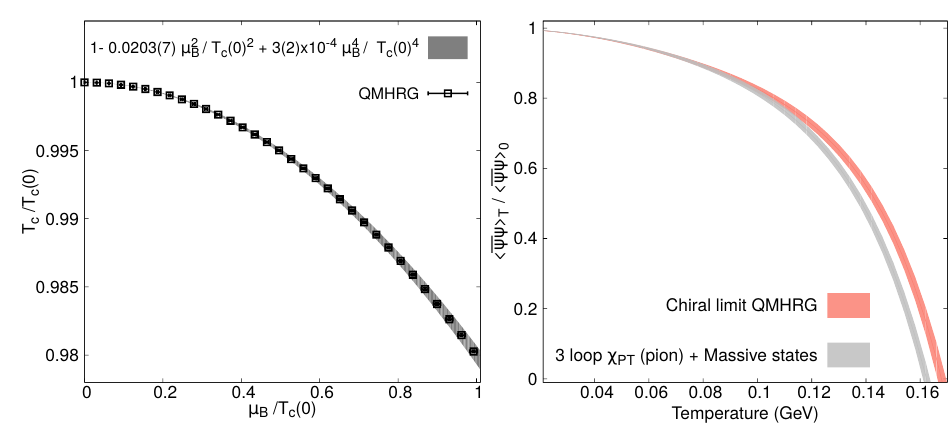
Figure 2. (Left) A fit to the pseudo-critical line between µ B / T ≲ 1 gave κ 2 = 0 . 0203(7) and κ 4 = − 3(2) × 10 − 4 . (Right) The ratio of the chiral condensate at a finite temperature to its zero temperature value compared to our calculation within QMHRG (orange band) compared to three loop χ PT results in Ref. [25] at finite temperature O ( T 6 ) augmented by heavier hadrons used in our work (gray band).